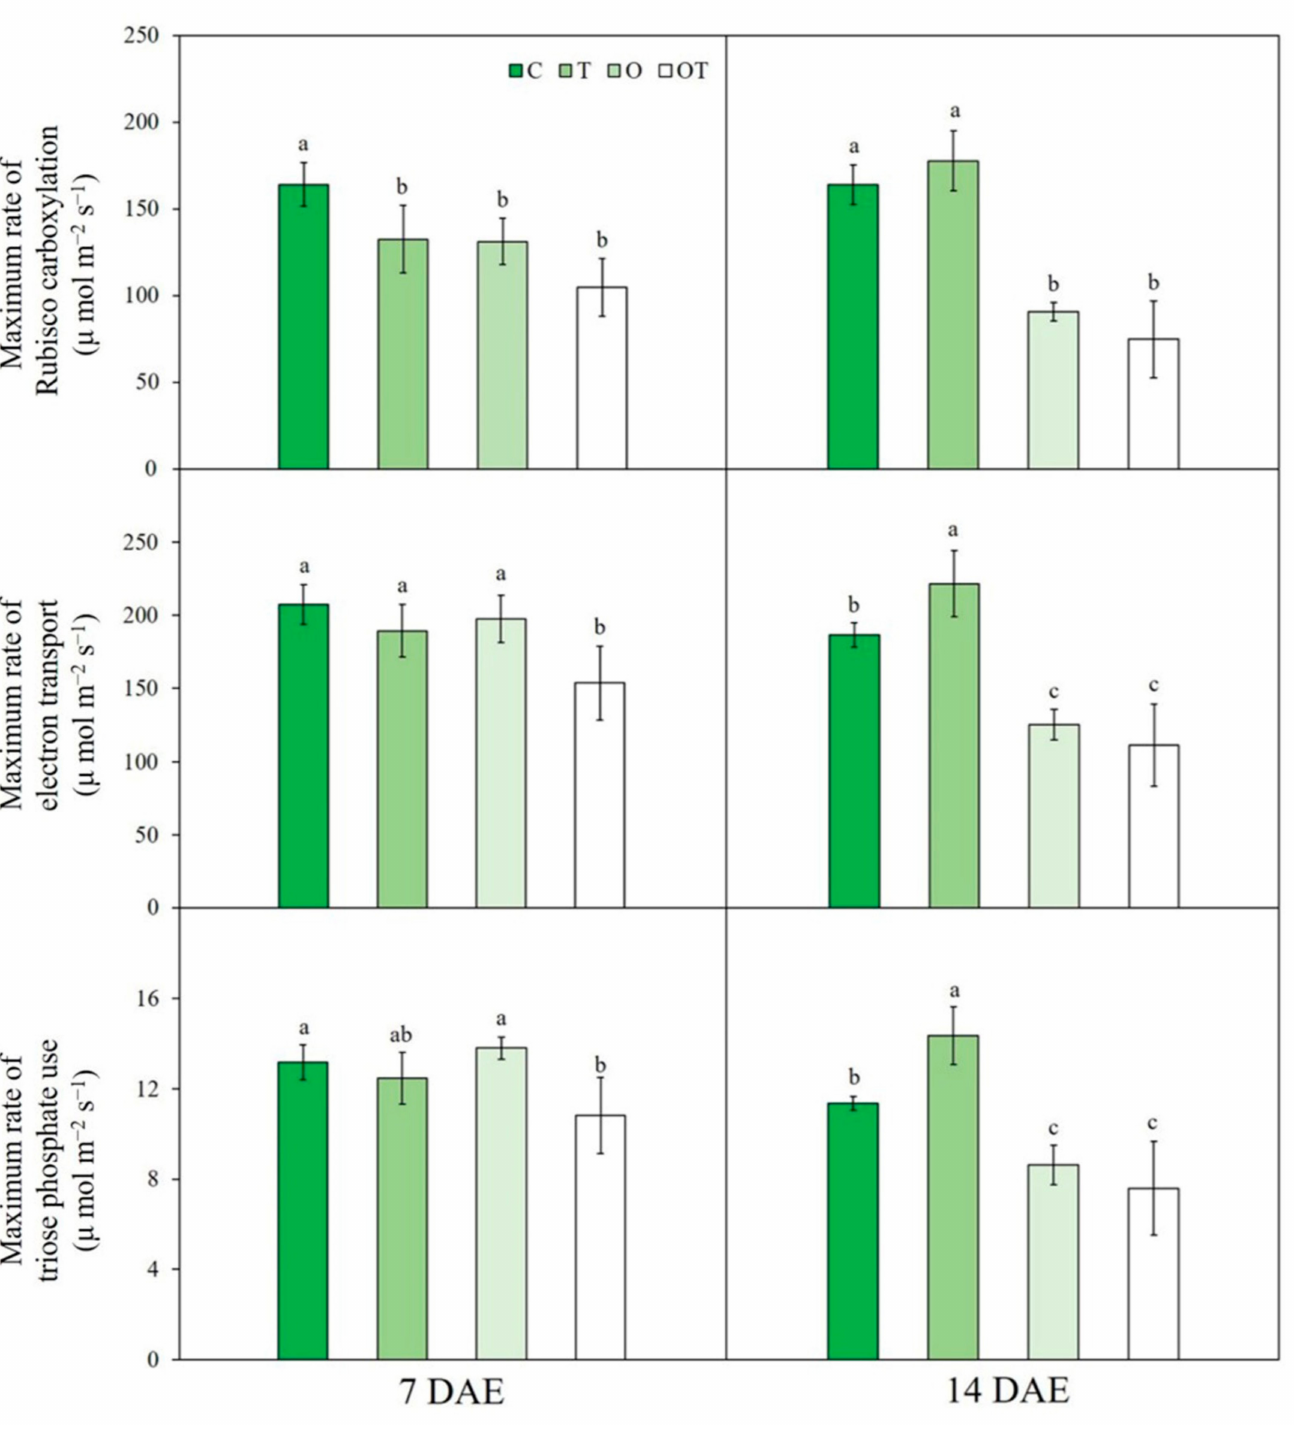
Figure 2. The maximum rate of ribulose 1,5-bisphosphate carboxylase/oxygenase (RuBisCo) carboxylation, electron transport, and triose phosphate use of Brassica juncea L. under different ambient and supraoptimal temperatures and O 3 concentrations at 7 and 14 DAE. Data are plotted as mean ± SD ( n = 5). Different letters indicate significant differences among treatments at p < 0.05 according to Tukey’s honestly significant difference test. C: ambient O 3 + optimal temperature; T: ambient O 3 + supraoptimal temperature; O: elevated O 3 + optimal temperature; OT: elevated O 3 + supraoptimal temperature; DAE: days after the beginning of